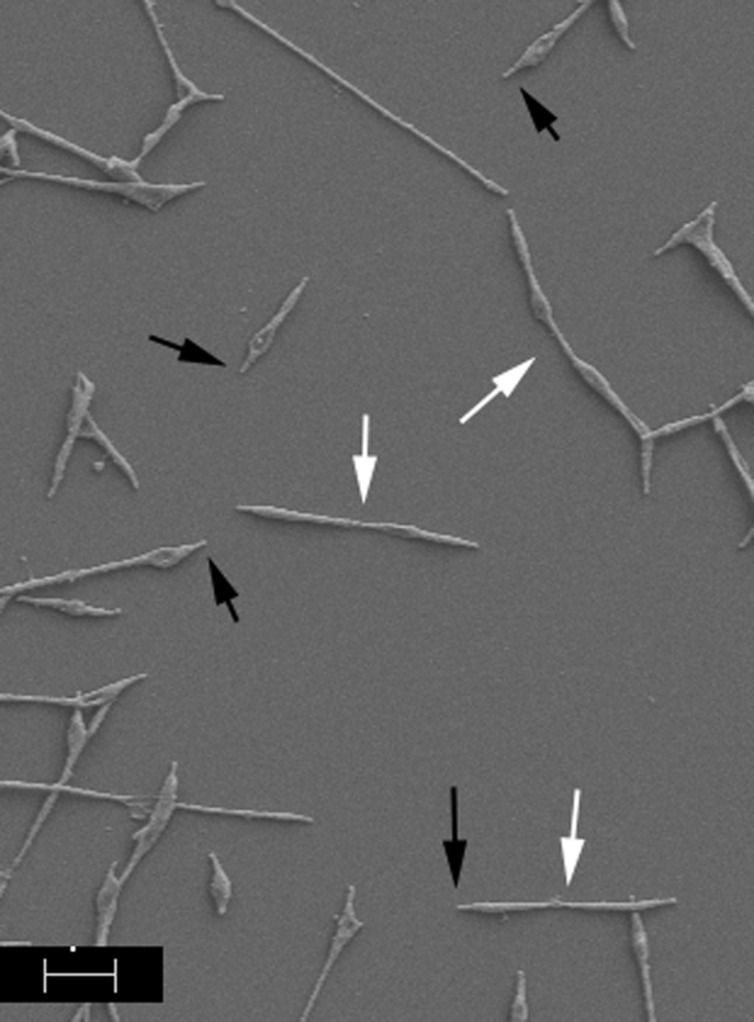
Scanning electron image of Mycoplasma pneumoniae cells. Cells were prepared according to Hatchel et al. (2006). Black arrows indicate AOs; white arrows indicate dividing cells. Scale bar, 1 μm.